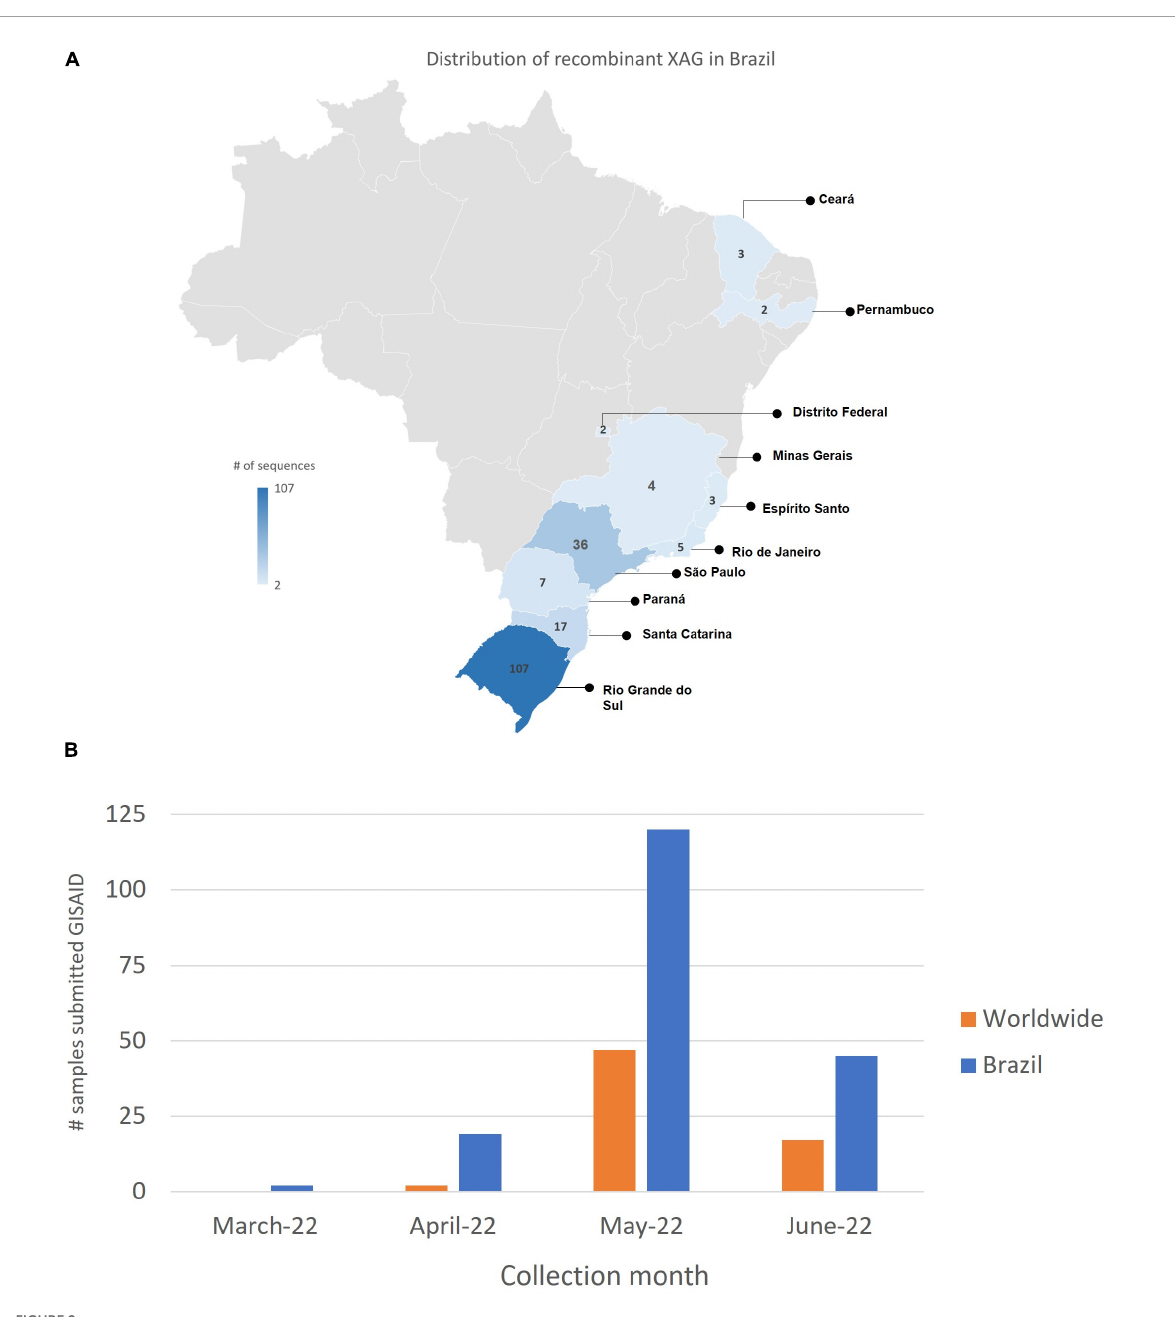
derived from Omicron BA.2. ∗ . A dataset with representative sequences of the following lineages was used: Omicron